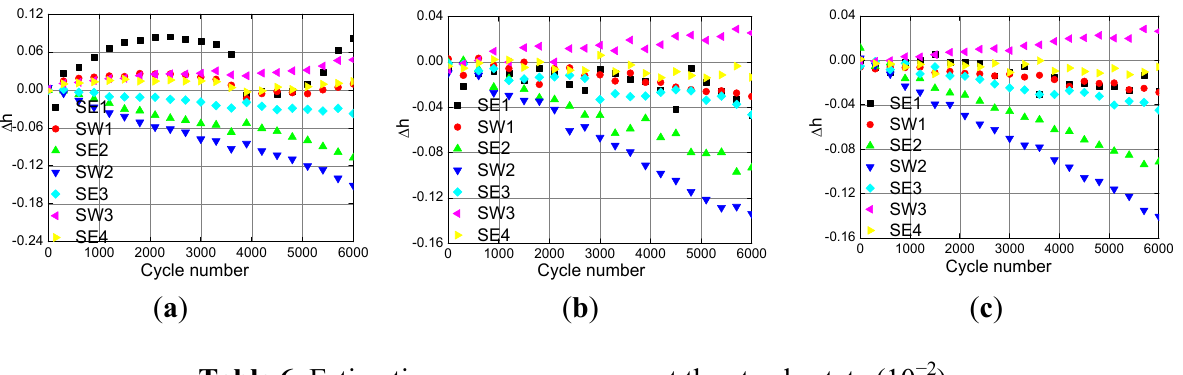
Table 6. Estimation error square sum at the steady state (10 − 2